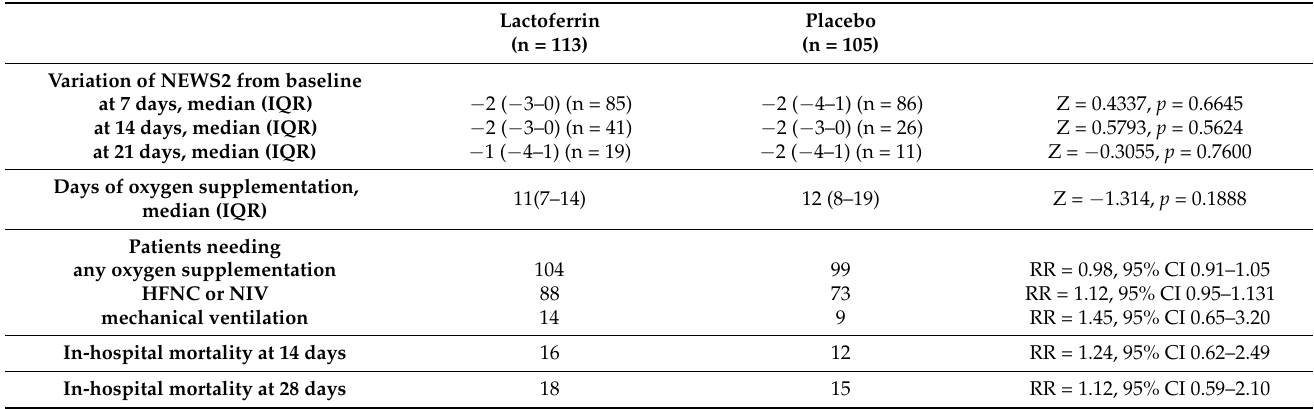
Table 4. Secondary outcomes. Data are expressed as number of patients or median (interquartile range, IQR) when appropriate.